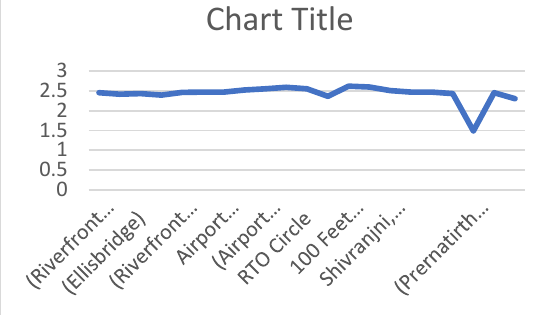
Figure 13: Observations at different locations